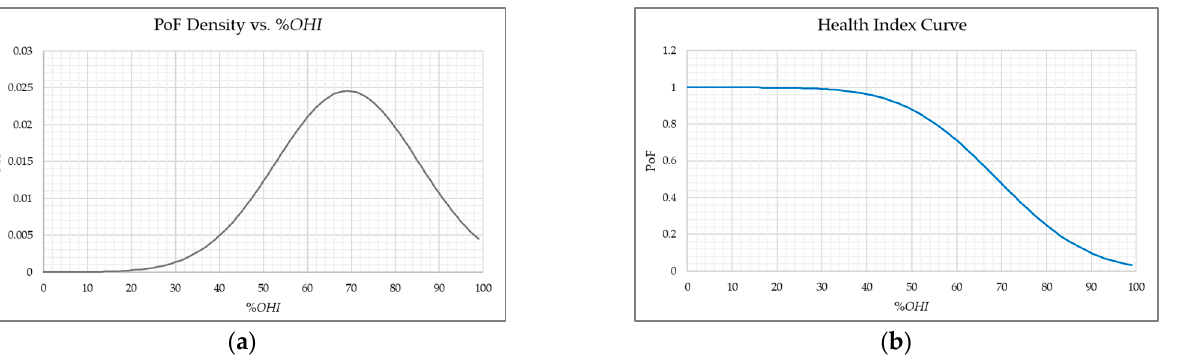
Figure 4. Normal distribution application on % OHI analysis: ( a ) failure probability density versus % OHI ; ( b ) HI curve.